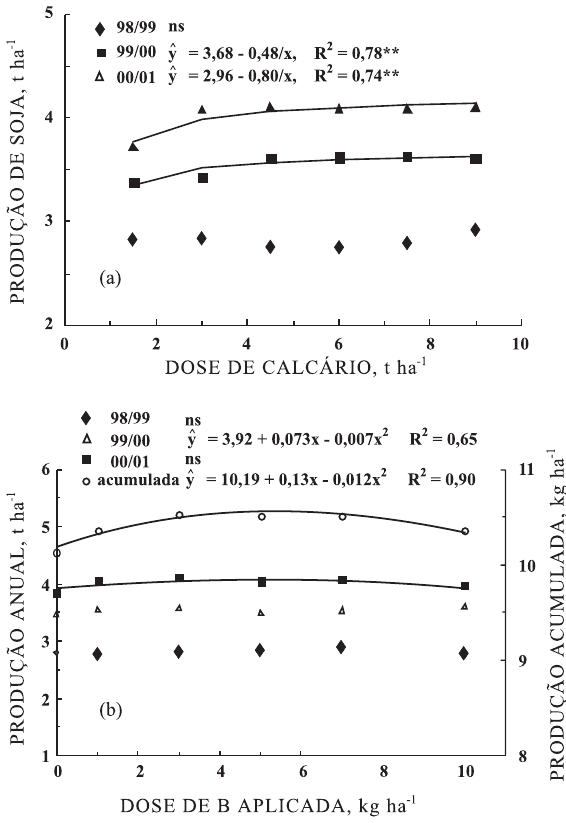
Figura 1. Produção de soja em função da calagem (a) e da adubação boratada (b) nos três anos do experimento. Para calagem, os dados se referem à média de seis doses de boro, e a resposta foi significativa pelo teste t (p < 0,05) até 4,5 t ha -1 no segundo e 3,0 t ha -1 no terceiro